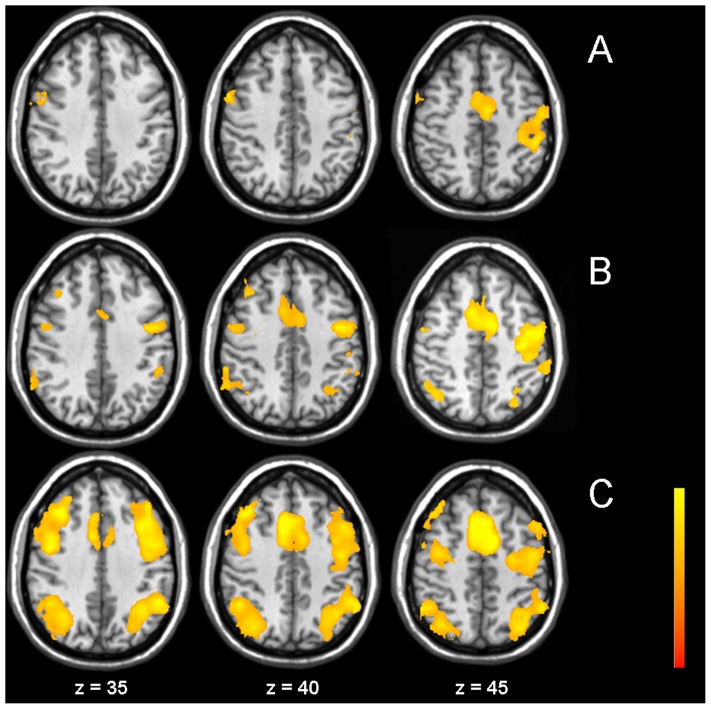
fMRI main effects.Group activation map over all subjects for the three different tasks alertness (A), 0-back (B), and 2-back (C) (Z>3.3, corrected p<0.01). Statistical maps are superimposed onto the MNI structural template. All MR Images shown here are in radiological order (image left is anatomical right).